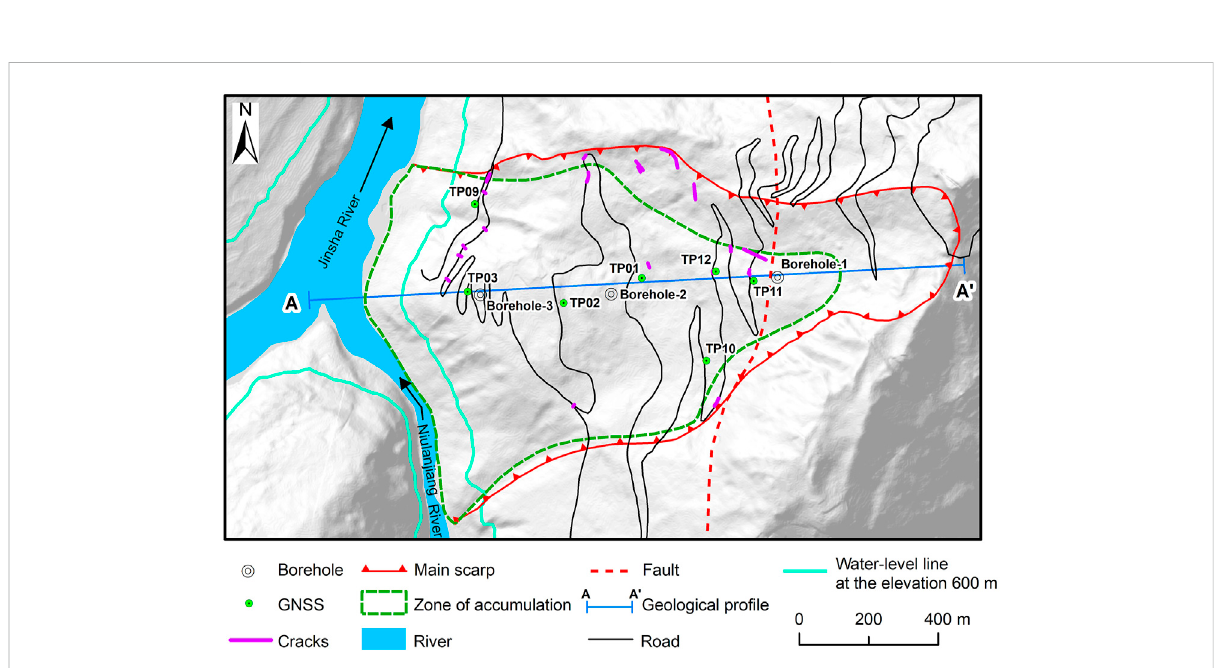
FIGURE 3 Plan of NLJL and locations of GNSS monitoring points, boreholes, cracks, and line of geological cross section (after CHIDI, 2021).